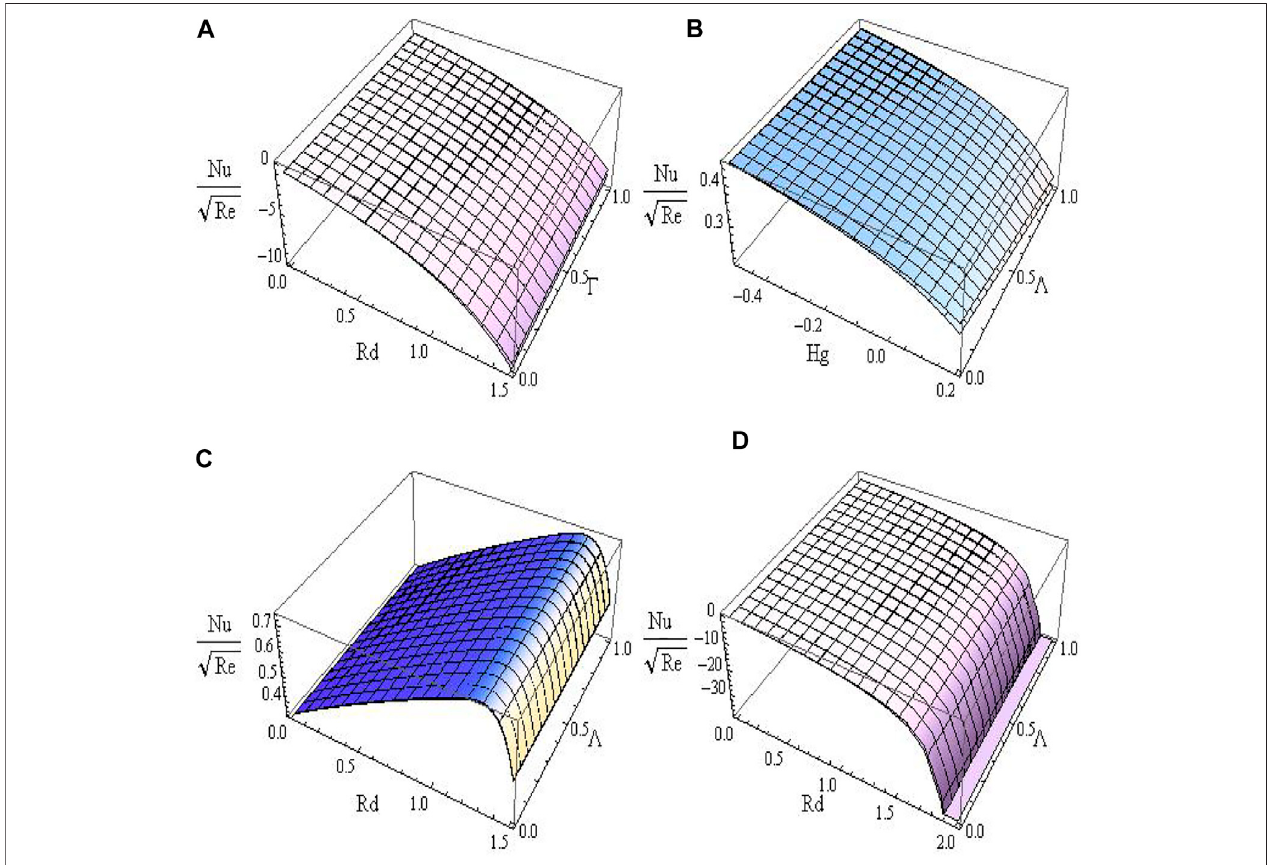
FIGURE 7 | The variations of “ Nu ” for various combinations of Rd, Γ , Λ , and Hg with (A) lower plate ( Λ (cid:1) 0.2) and upper plate ( Λ (cid:1) 0.0), (B) lower plate (Q (cid:1) 0.3) and upper plate (Q (cid:1) 0.0), (C) lower plate (Q (cid:1) 0.0 & Bi (cid:1) 0.5) and upper plate (Q (cid:1) 0.3 & Bi (cid:1) 0.5), and (D) lower plate (Q (cid:1) 0.0 & Bi (cid:1)− 0.5) and upper plate (Q (cid:1) 0.3 & Bi (cid:1) −